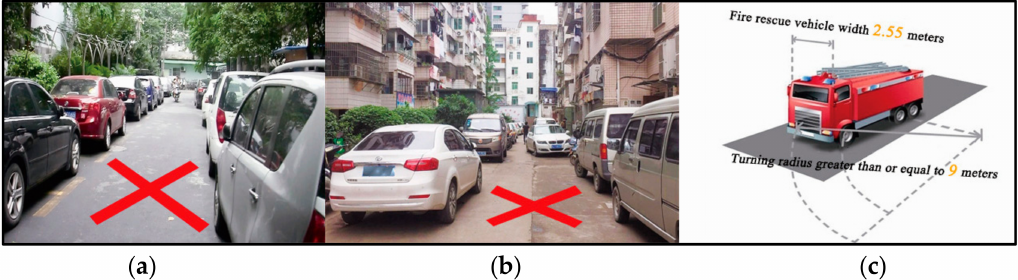
Figure 4. Road congestion caused by private cars: ( a , b ) private cars parking chaotically in a residential area; and ( c ) fire-engine traffic